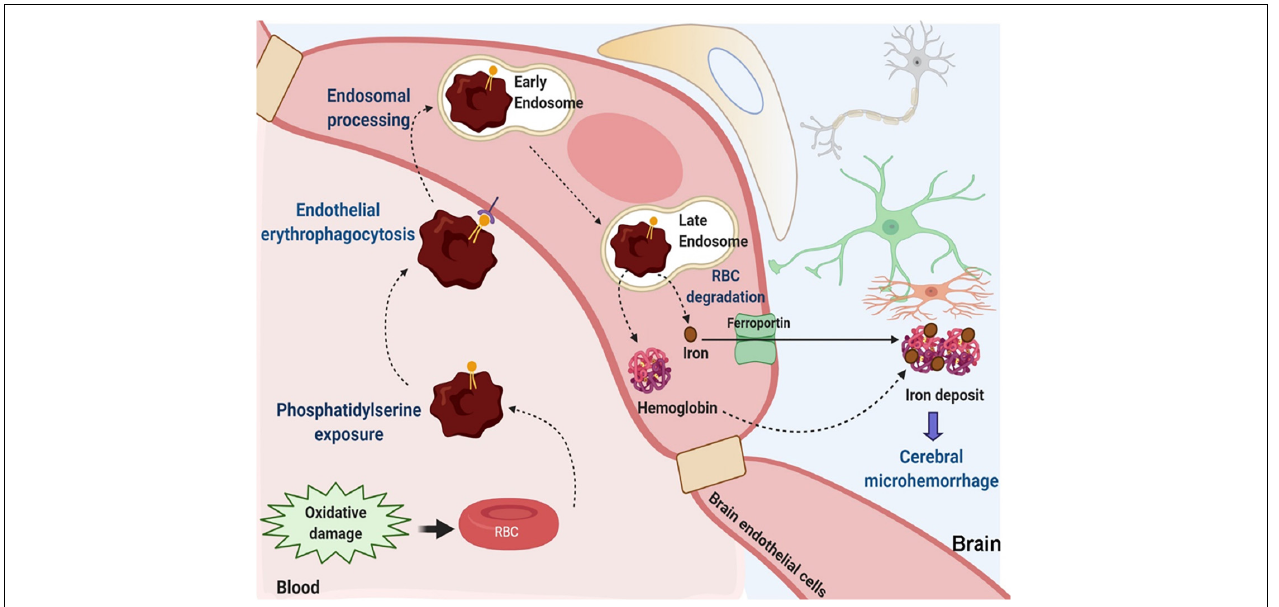
FIGURE 8 | Suggested mechanisms contributing to brain endothelial erythrophagocytosis mediated Prussian blue-positive cerebral lesions. Oxidative stress and phosphatidylserine exposure increase phagocytosis of RBCs by the brain endothelium. Other mechanisms including CD47 reduction may also be involved. Engulfed RBCs undergo endosomal sorting and ultimately undergo degradation within the late endosomes/lysosomes. This increases intracellular pools of iron-rich RBC degradation products, hemoglobin and iron. Free iron may be effluxed from the brain endothelial cells via the abluminal iron-exporter ferroportin. Alternatively, hemoglobin may migrate across the brain endothelium. Migration of iron-rich RBC degradation products across the brain endothelial cells can increase the brain abluminal iron, resulting in Prussian blue-positive CMH-like lesion development.